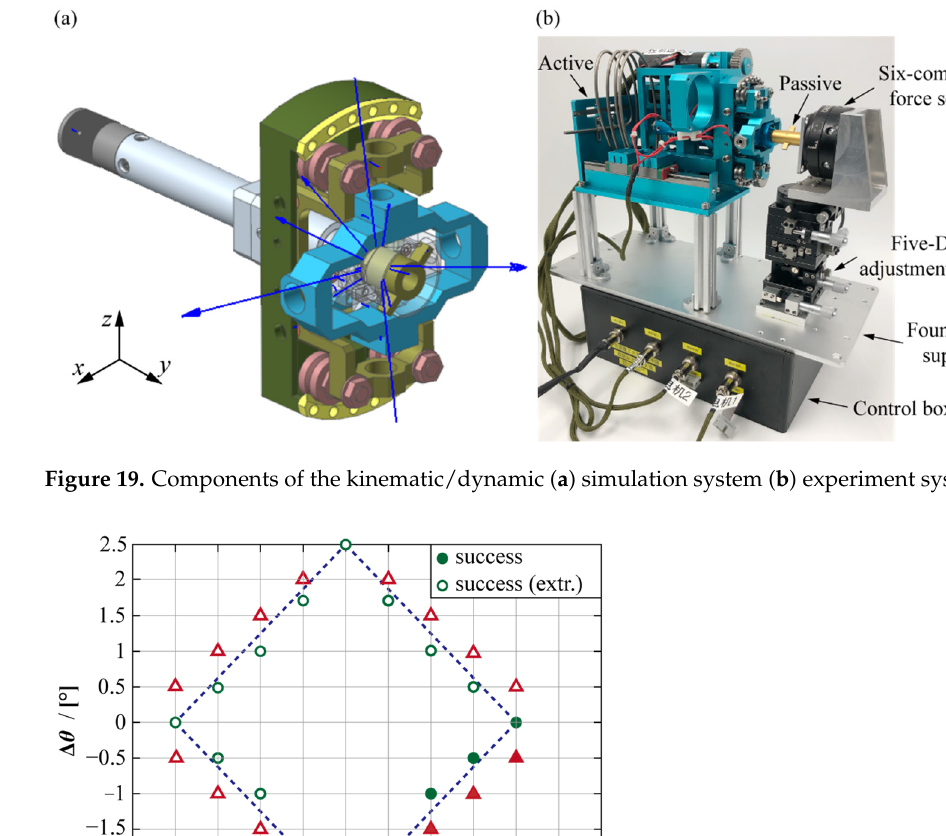
Figure 19. Components of the kinematic/dynamic ( a ) simulation system ( b ) experiment system.